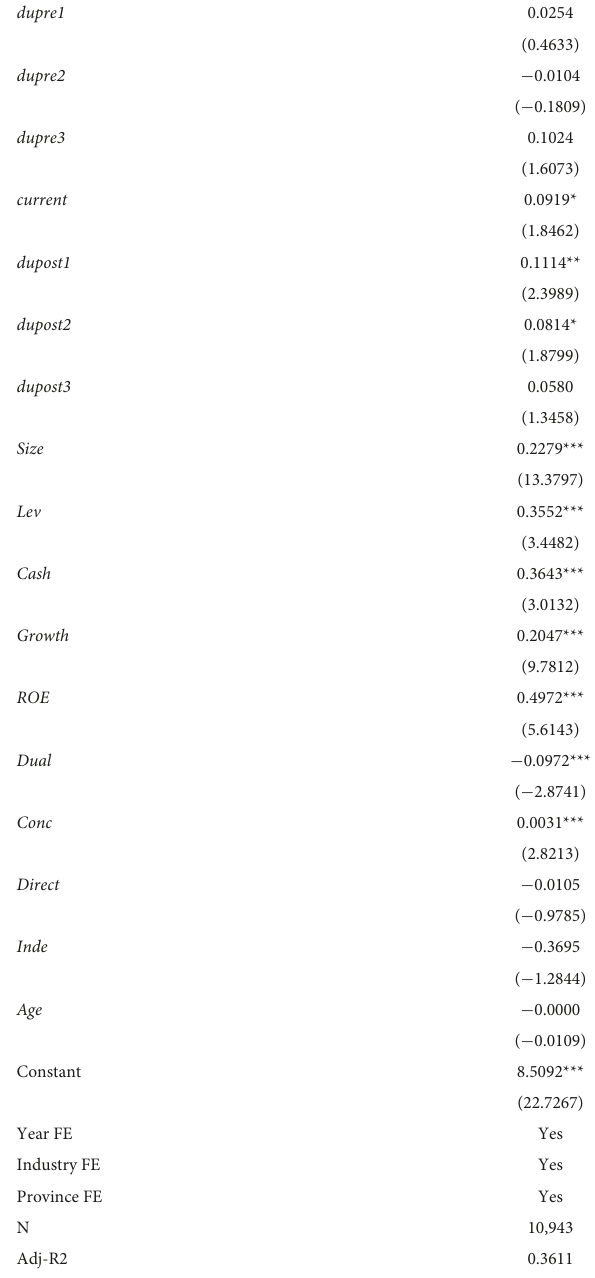
TABLE 4 Results of alternative parallel trend